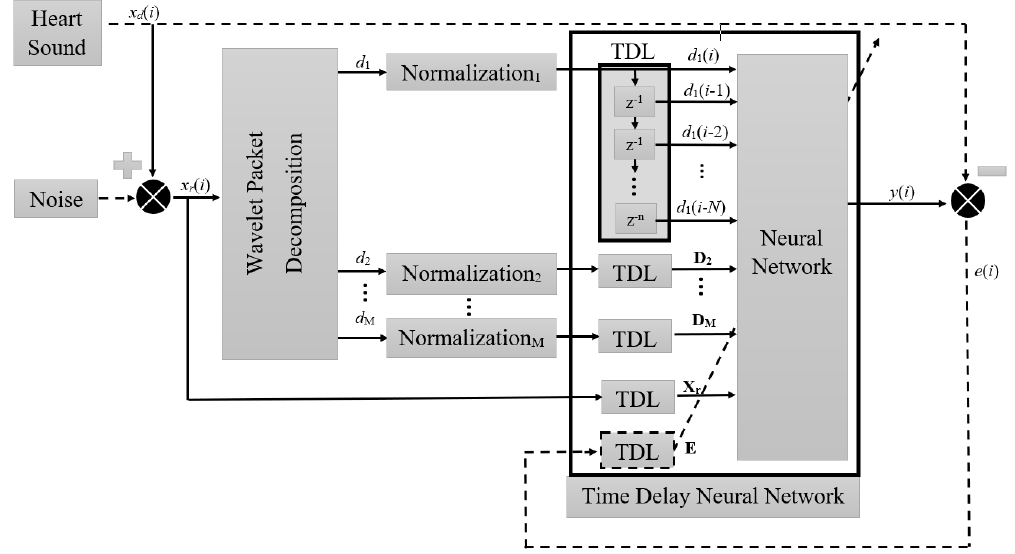
Figure 2. The block diagram of the proposed system, the dashed lines represent the training scheme of